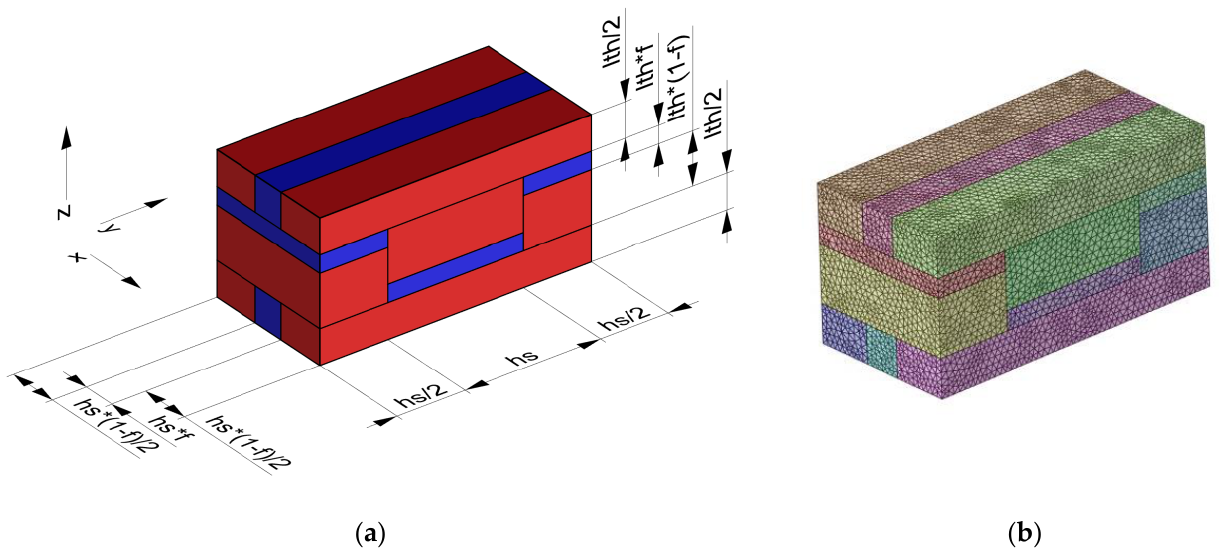
Figure 5. ( a ) RVE dimensions according to the material fraction f. ( b ) Mesh adopted in the simula- tion.